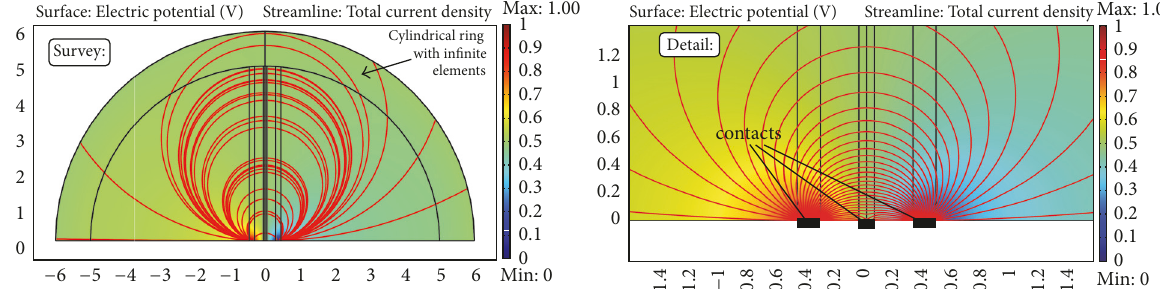
Figure 5: Finite element model of a resistive device with three contacts at the lower boundary (= 𝑥 -axis). The plots were obtained by FEM simulations with COMSOL MULTIPHYSICS. They show the potential distribution and the current streamlines. The entire upper half plane is conductive with piezoresistance according to (5) and (6a)–(6c) with 𝜌 0 = 1Ω m and the piezoresistive coefficients for low n-doped silicon ( 𝜋 11 = −1.022/ GPa, 𝜋 12 = 0.534/ GPa, 𝜋 44 = −0.136/ GPa). Pure strain is neglected. The outer contacts are 0.15 m long, the center contact is 0.1m long, and the spacing between contacts is 0.25 m. The thickness into the drawing plane is 1m. The left contact is forced to 1V, the right contact is forced to 0 V, and the center contact is floating (i.e., no current flows in or out). The infinite boundary is modeled with infinite elements. The mesh has 1.4 million elements. At zero mechanical stress the center contact is at 0.5 V and the input resistance is 1.88262 Ω . At 𝜎 = 100 MPa the output voltage increases 57 nV and the input resistance decreases − 2.443%. At 𝜎 = 100 MPa the output voltage decreases 𝑥𝑥 𝑦𝑦 − 56 nV and the input resistance decreases − 2.441%. At 𝜎 = 100 MPa the output voltage decreases − 2.5 𝜇 V and the input resistance decreases 𝑥𝑦 − 1.218%. All these resistance changes deviate less than 10ppm from theory (12a)–(12c). The changes in output voltage should be zero according to theory and the small deviations are probably due to insufficiently fine